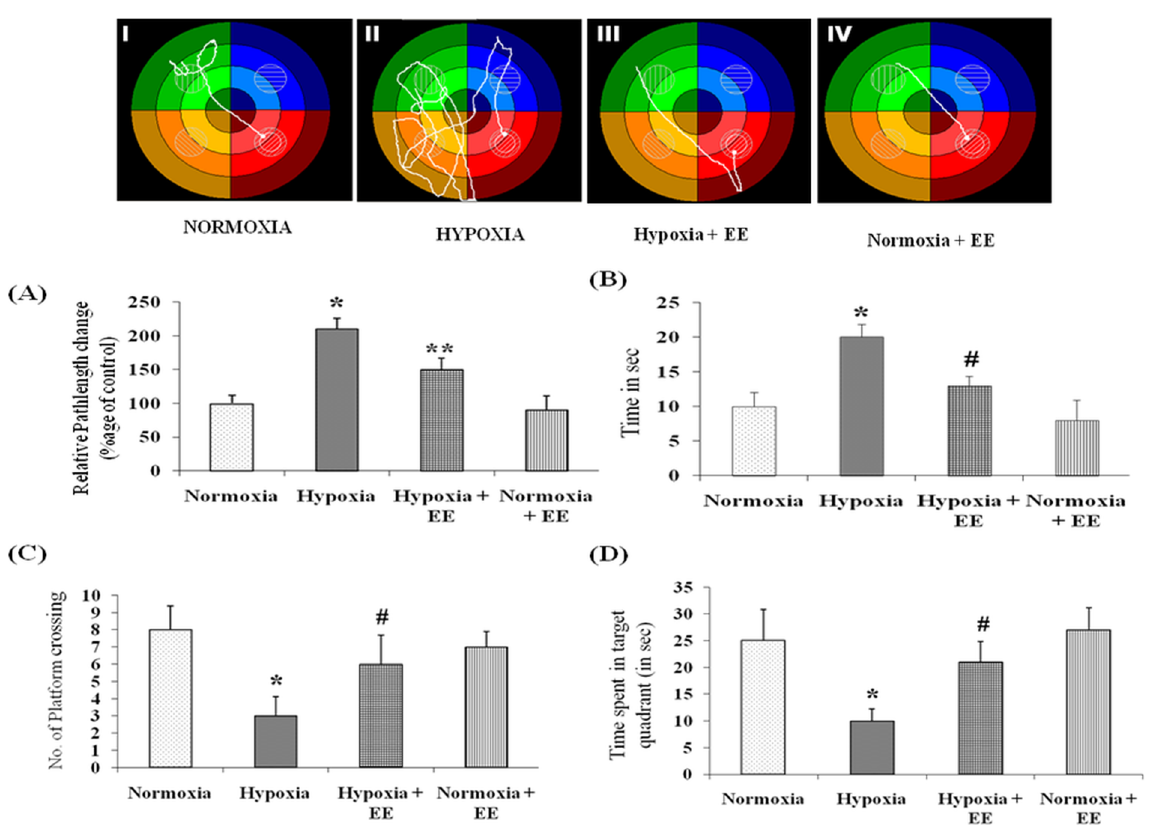
Figure 1. Behavior changes was studied using Morris Water Maze test and representative tack sheet showing memory test of Control (I), Hypoxia (II), Enriched environment with Hypoxia (III) and Enriched environment without hypoxia (IV) exposure. Latency (A) and Pathlength (B) were increased on HH exposure whereas EE revert back these effects to normal. In contrast HH leads to lessen the number of platform crossing (C) and time spent in target quadrant (D) and EE again showed promising effect by increasing their value. Data represents Mean 6 SEM. ‘‘*’’ and ‘‘ # ’’ represents p , 0.001 when compared to control and hypoxic group whereas ‘‘**’’ represents p , 0.05 when compared to hypoxic